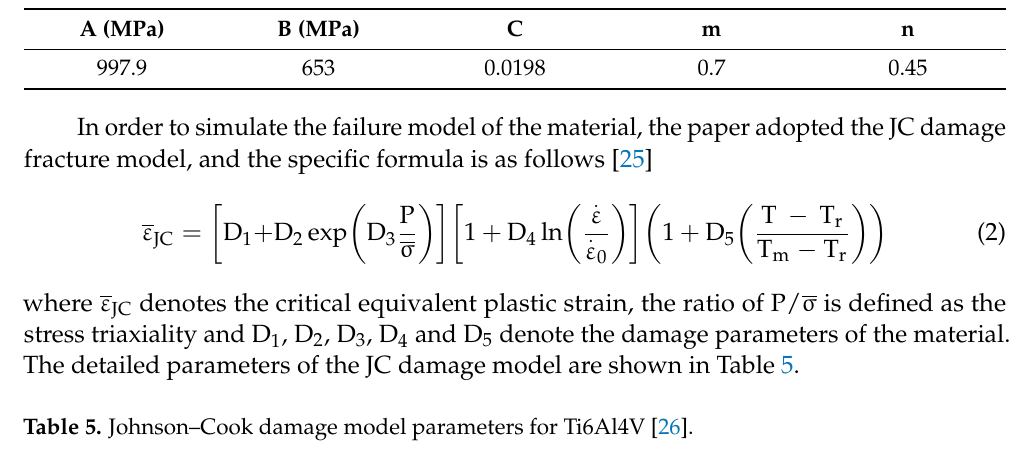
Table 4. Johnson–Cook constitutive model parameters for Ti6Al4V [24].